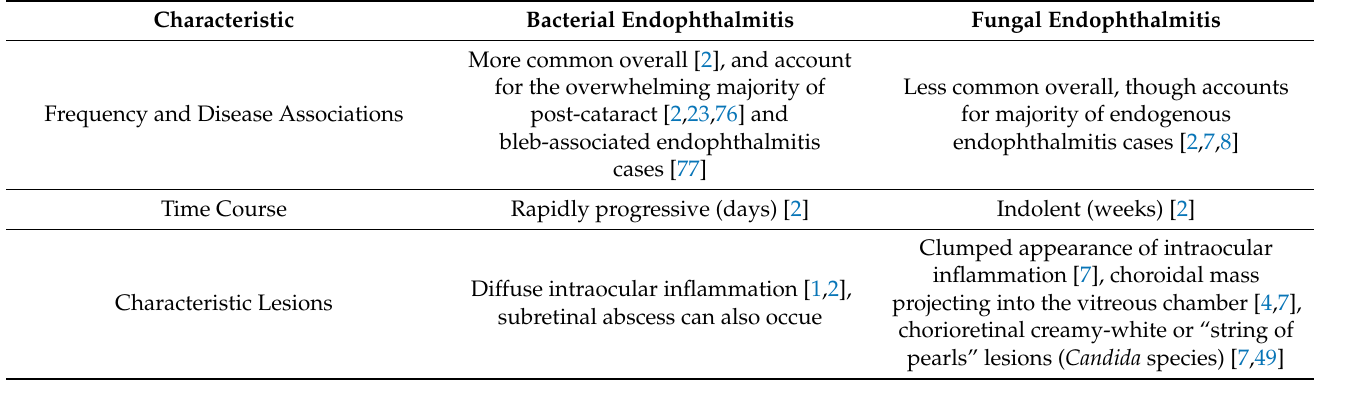
Table 2. Characteristics distinguishing bacterial endophthalmitis from fungal endophthalmitis. Characteristic